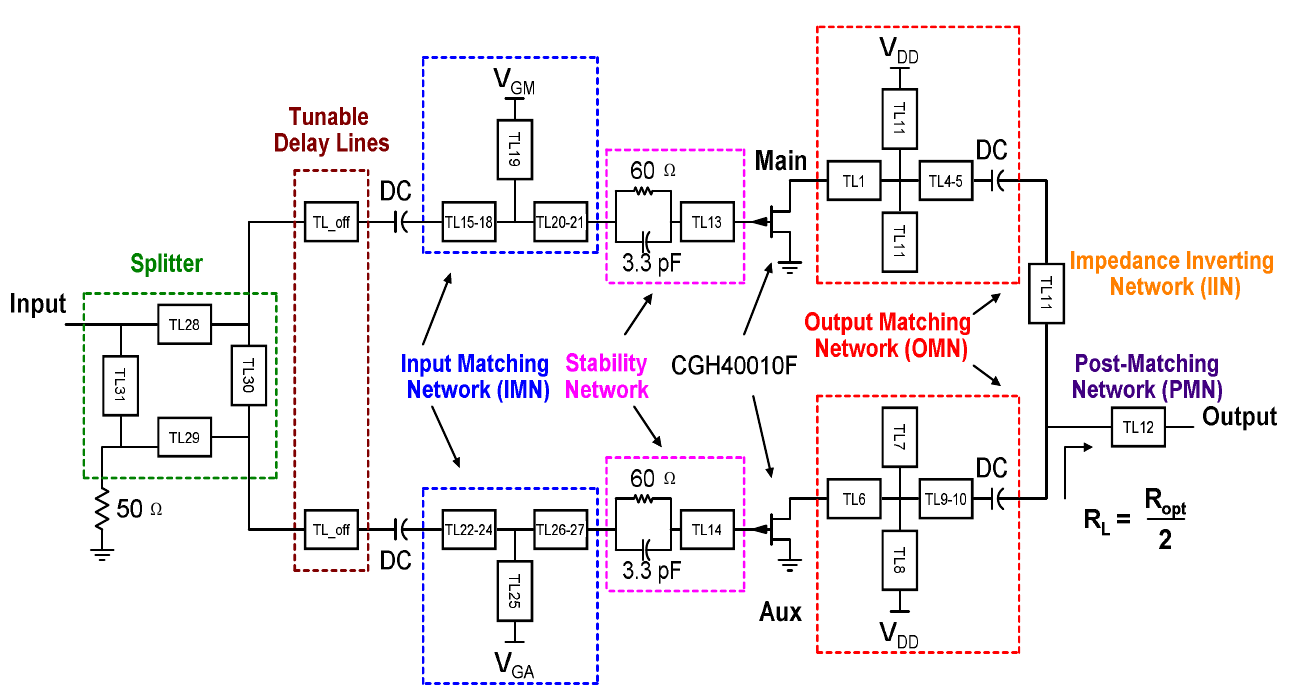
Figure 1. Schematic of the proposed Doherty power amplifier.